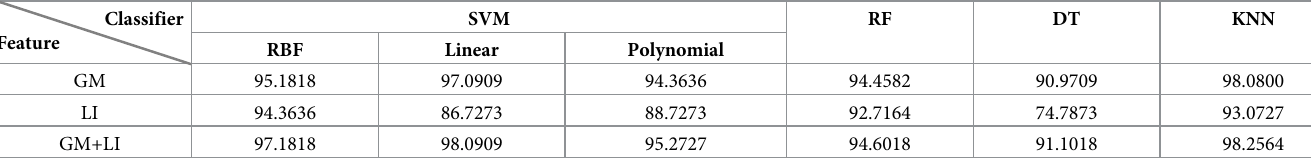
Table 6. Classification results in AD versus NC under three kinds of features(%).